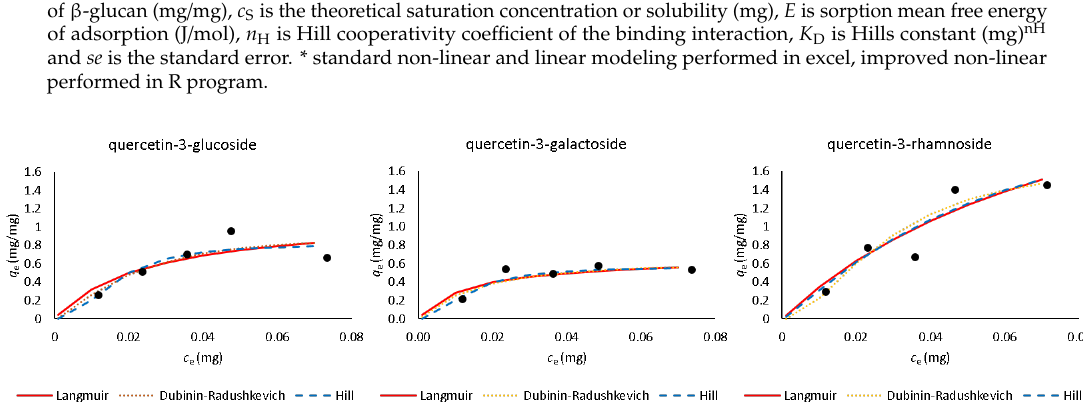
Figure 3. Langmuir, Dubinin-Radushkevich and Hill isotherms of quercetin derivatives adsorption onto β-glucan obtained with standard non-linear regression.